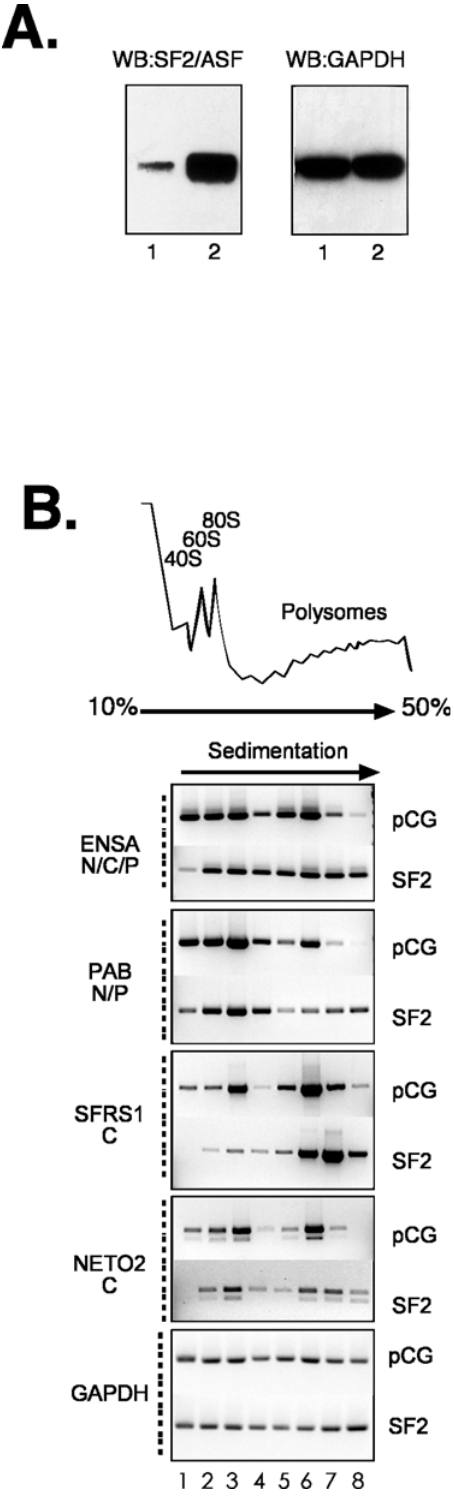
Figure 5. Polyribosome association of endogenous SF2/ASF mRNA targets. A) Western blot analysis of cytoplasmic extracts prepared from cells transfected with pCGT7 of pCGT7 SF2/ASF (lanes 1 and 2, respectively). Blots were probed with anti-SF2/ASF and anti- GAPDH (left and right panel, respectively). B) Polyribosome association of endogenous mRNAs. Cytoplasmic extracts from control or pCGT7 SF2/ASF cells were resolved by sucrose gradient fractionation. The upper panel shows the absorbance of rRNA across the gradient,